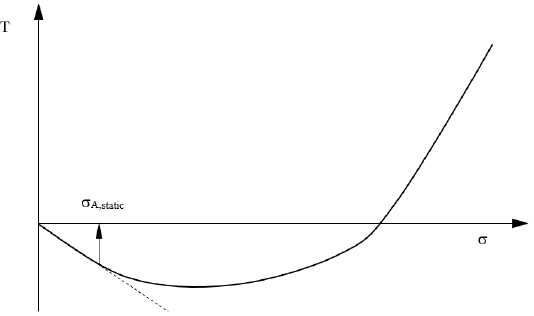
Figure 3. Temperature-versus-stress curve measured during a tensile static test and material fatigue limit evaluation according to [8].